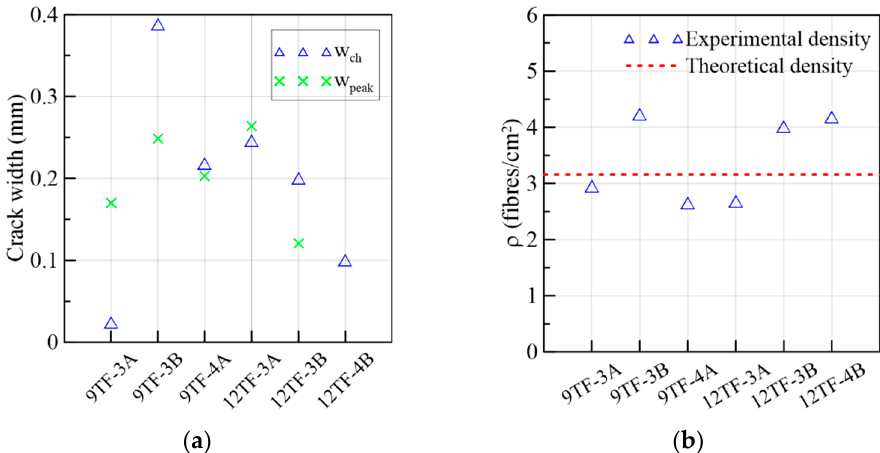
Figure 18. Mechanical results of 9TF-12TF specimens of the transverse direction: ( a ) crack widths at the change in behavior and at the peak load and ( b ) fiber densities.